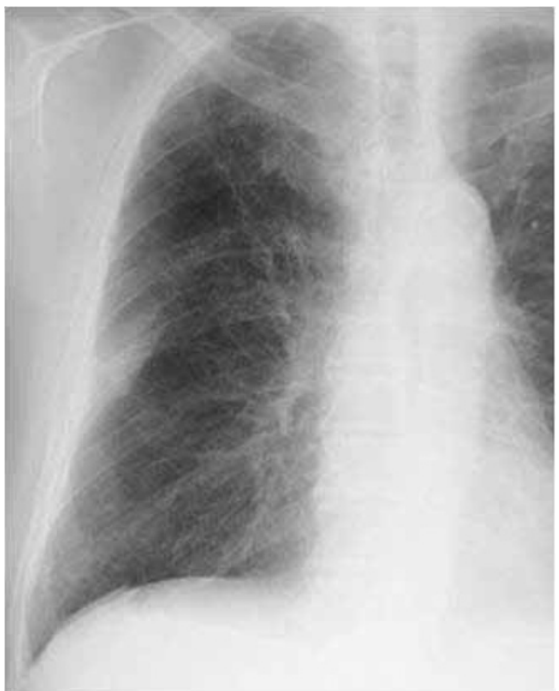
Figure 4. Chest radiograph at the time of discharge, which showed regression of hemopenumothorax, although small amount of interlober fluid was